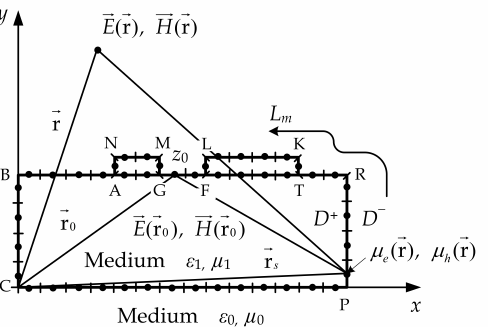
Figure 4. Rectangular geometry of a slot line